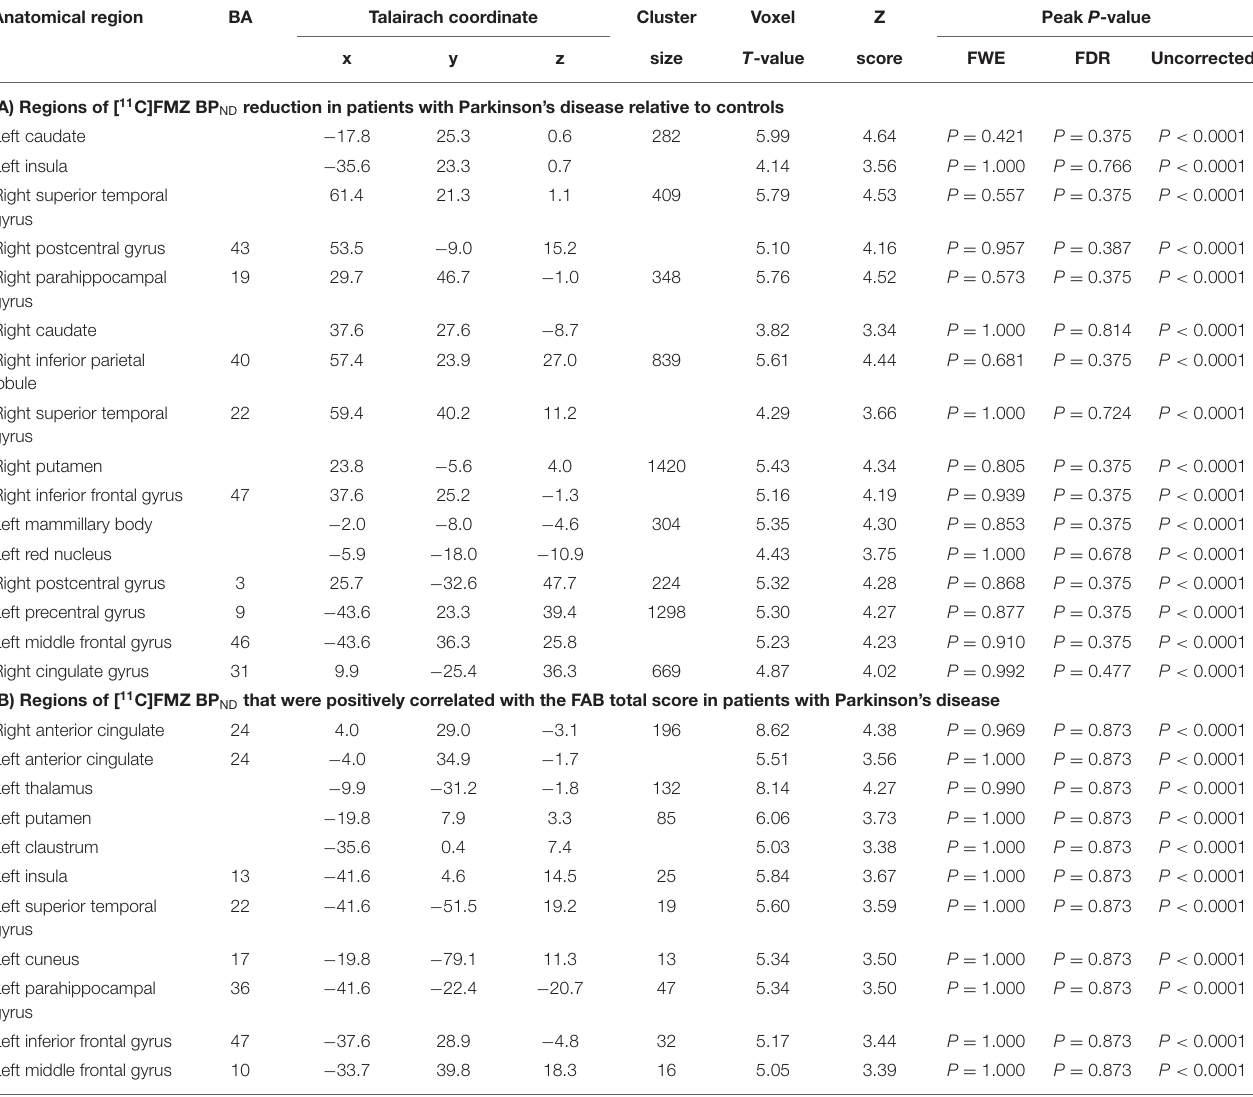
TABLE 3 | Statistical parametric mapping (SPM12) results. Anatomical region BA Talairach coordinate Cluster Voxel Z Peak P -value z size T -value score FWE FDR